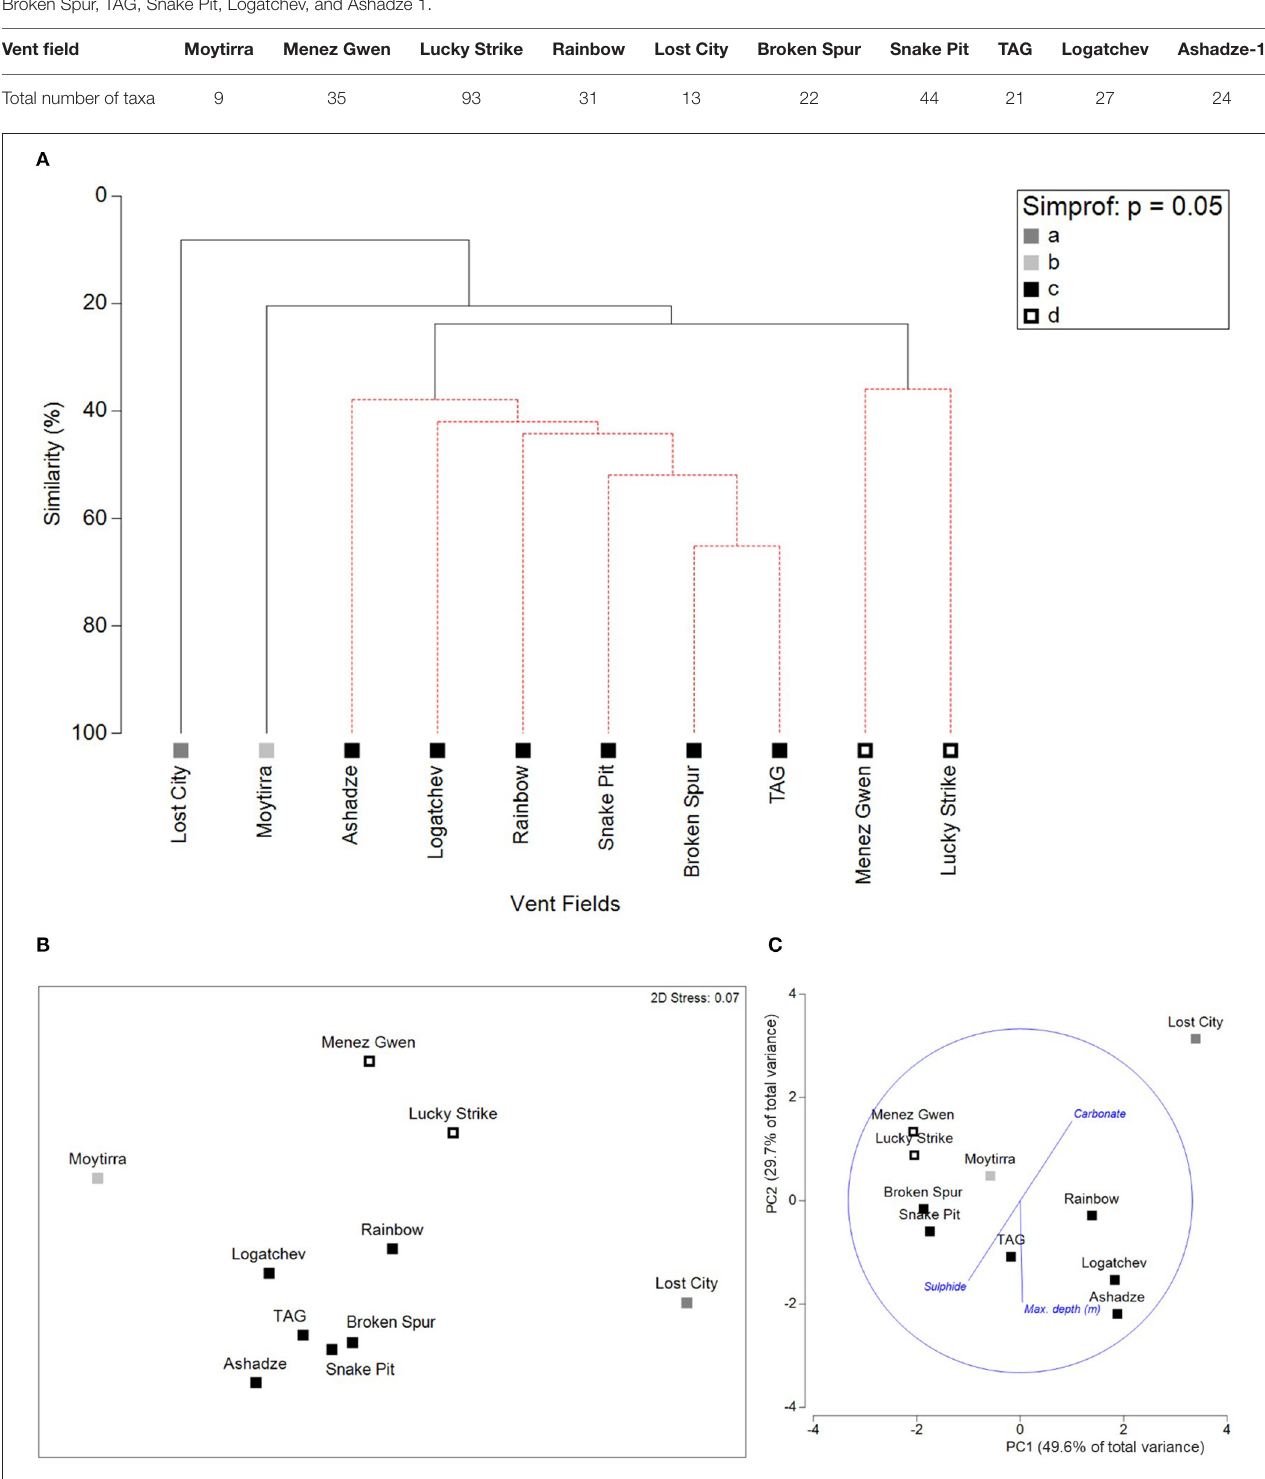
FIGURE 3 | (A) CLUSTER diagram of vent field similarity; (B) Non-metric Multidimensional Scaling (nMDS) plot of vent field similarity; (C) PCA of environmental variables, vectors displayed are the environmental variables (identified by the BEST test) with the strongest correlation with the presence-absence of taxa at the different vent